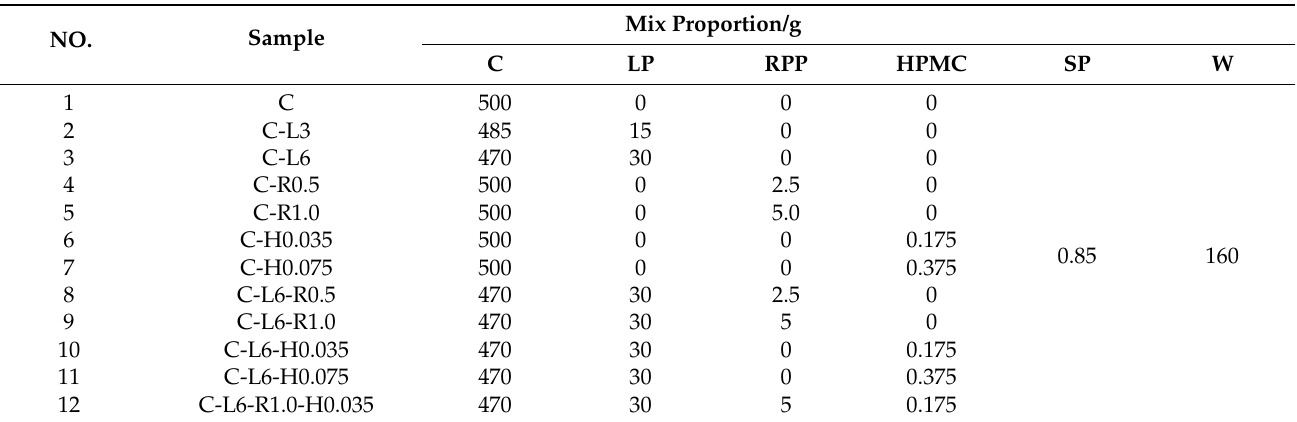
Table 5. Mix proportion of cement compound paste.